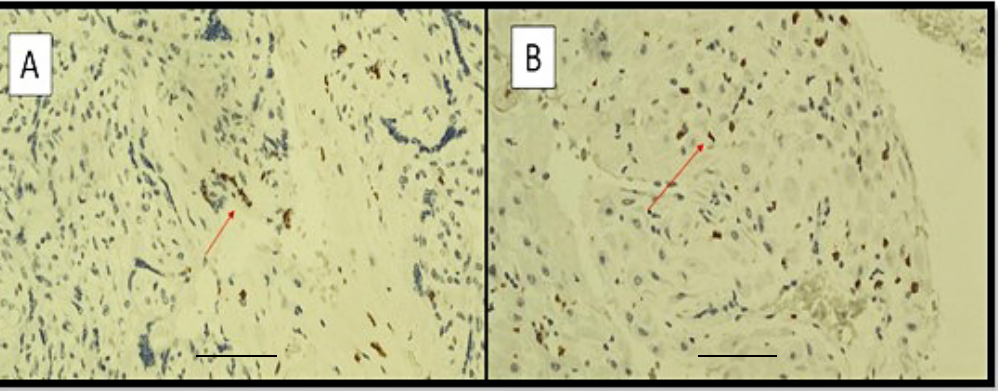
Figure 3. Examples of the presence of CD8 + T lymphocytes in intervillous space ( A ) and basal plate ( B ) from a mother belonging to CIC group. Note that, in our work, there was statistically significant difference only between CIC and control group but not between CIC and CNIC group. (Immunohistochemistry for CD8, Original Magnification 20×, red arrows indicate CD8 positive lymphocytes, scale bar: 350 µm).